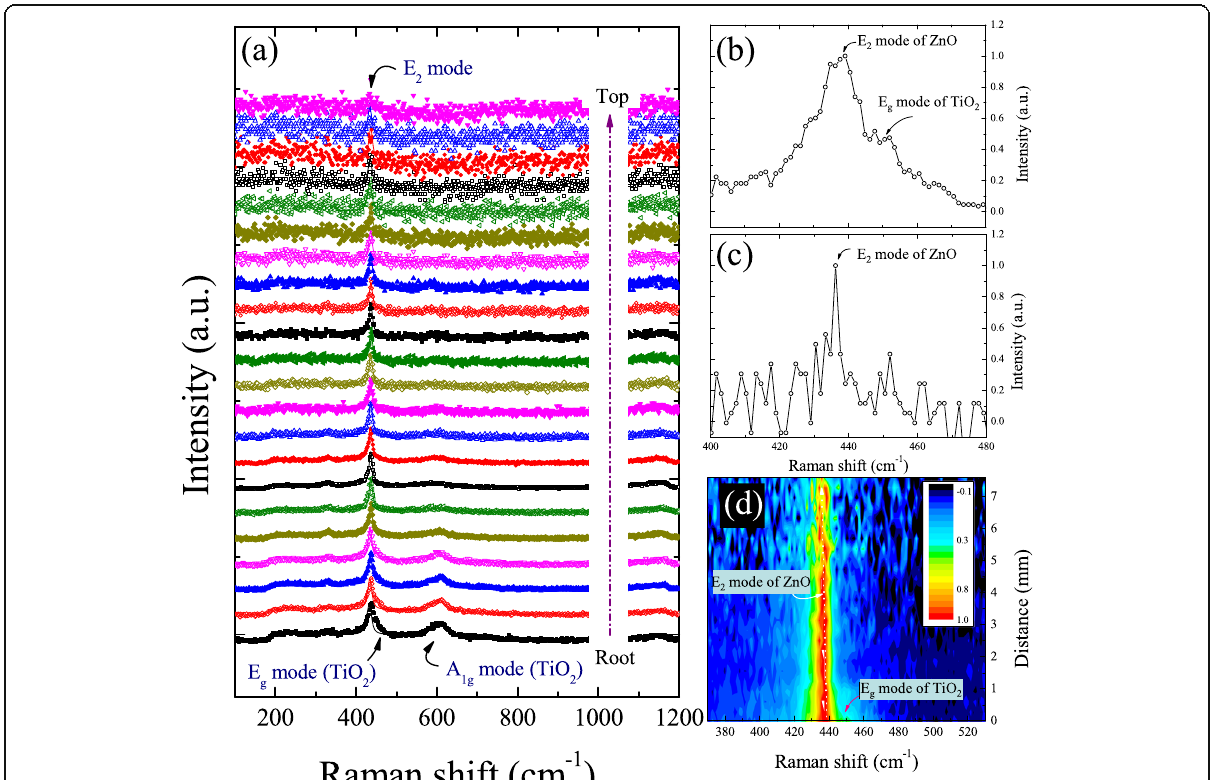
Fig. 3 a A series of Raman spectra of E 2 mode taken along the growth direction. Corresponding Raman spectra b at the bottom and c at the top of the tip-like ZnO nanowire. d Two-dimensional map of intensity and length dependence of Raman spectra taken at room